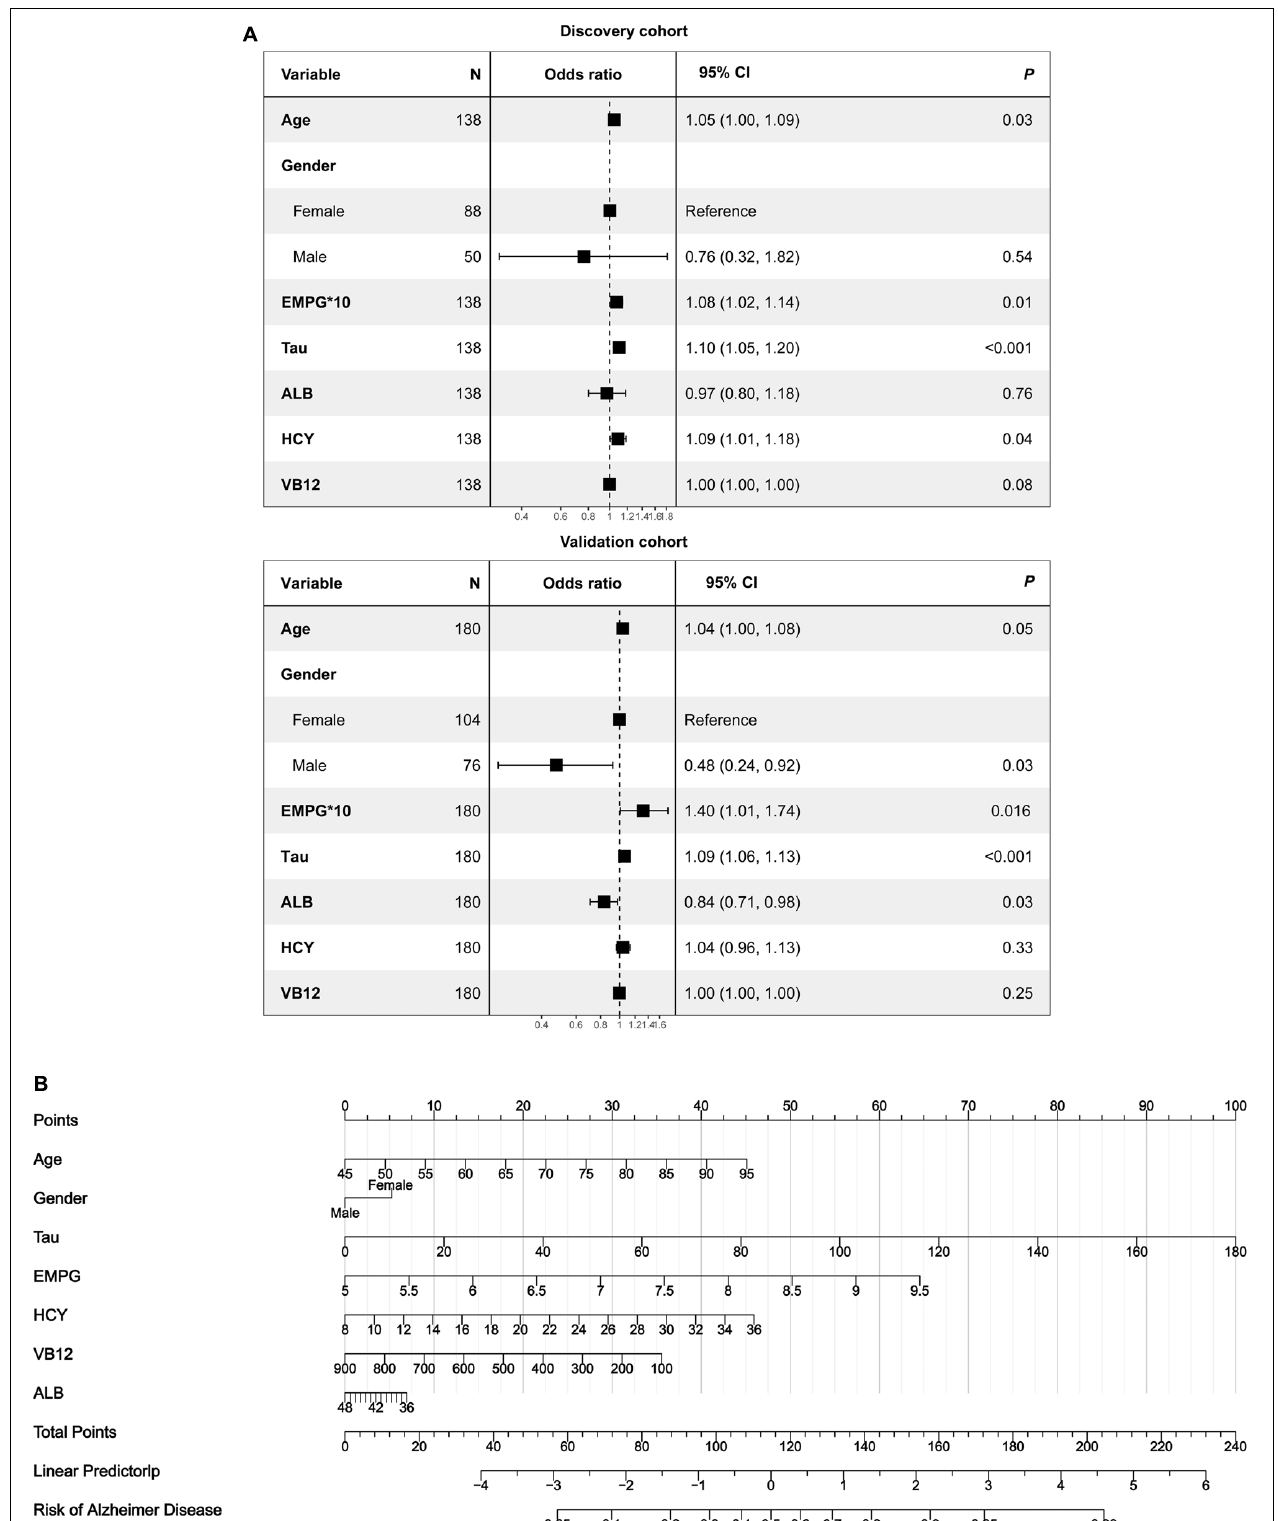
FIGURE 7 | The nomogram for differentiating aMCI and AD. (A) Forest plot of the predictive value of the selected features for multivariable analyses. (B) A predictive nomogram based on clinicopathological features and total Tau.